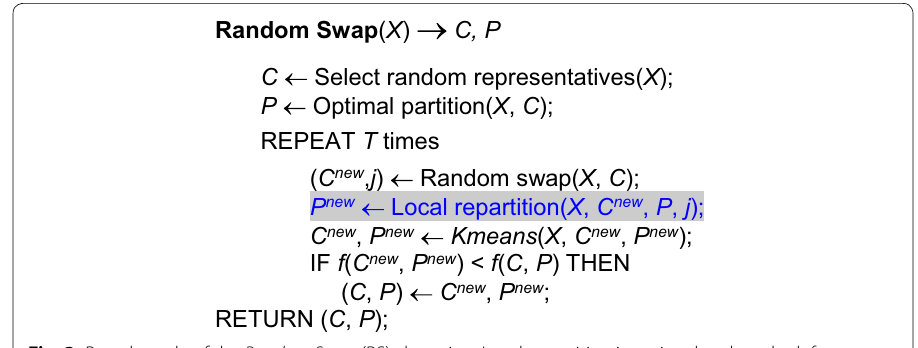
Fig. 3 Pseudo code of the Random Swap (RS) clustering. Local repartition is optional and can be left out especially if k-means is iterated 2 or more times